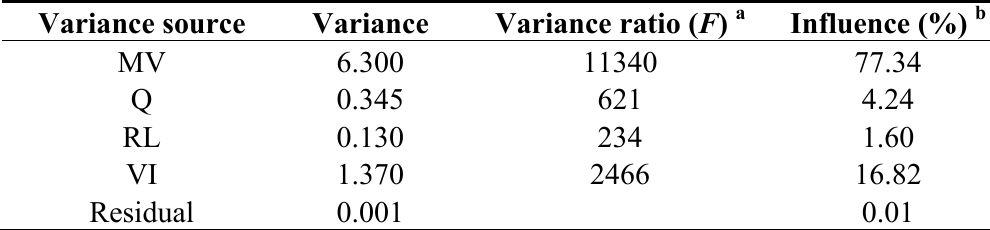
Table 2. Analysis of variance for peak height in Table